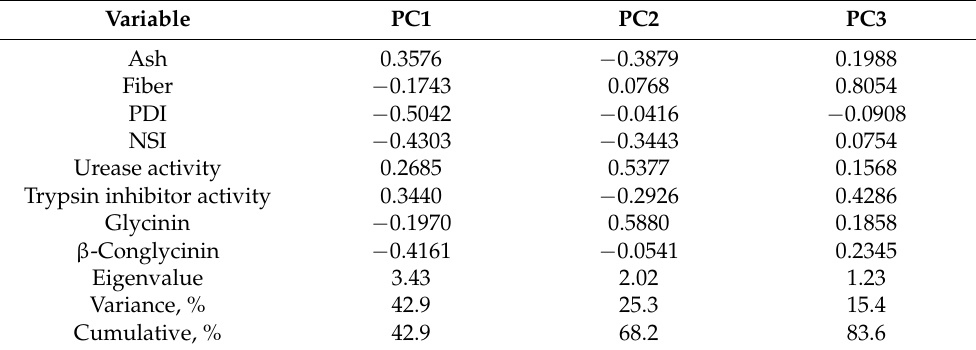
Figure 2. ( A ) Dendrogram of Cluster analysis (grouping of SBM sources base on their chemical composition and physicochemical properties); ( B ) score plot of PCA (grouping of SBM sources based on their chemical composition and physicochemical properties for component 1 (43% of variation) and component 2 (25% of variation)). Table 5. Principal Component Analysis (PCA) of chemical composition and physicochemical properties of tested soybean meals (SBMs) processed on the same production line with beans from different origins.